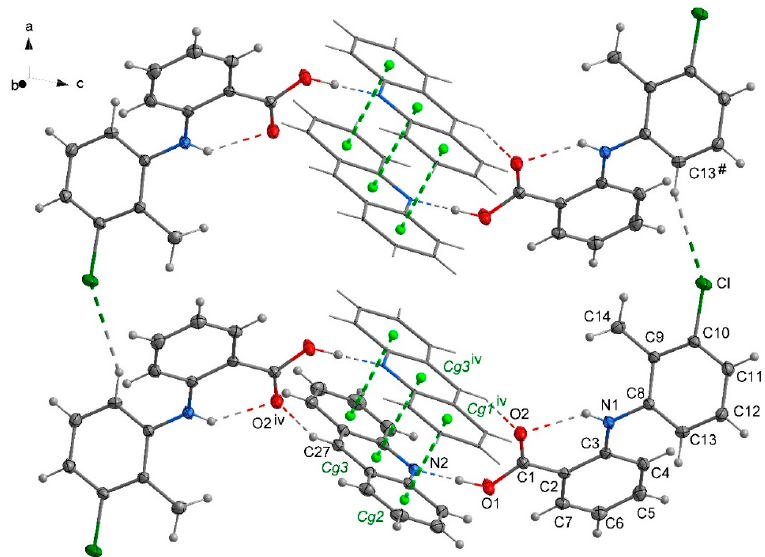
Figure 4. Packing crystal 3 showing arrangement of the complexes of acridine and tolfenamic acid. Stacking interactions of acridine molecules are shown by green dashed lines linking centers of aromatic rings (centroids of rings-Cg-marked as green balls; Cg1 (C28/C29/C30/C31/C32/C33); Cg2 (C21/C22/C23/C24/C25/C26); Cg3 (N2/C21/C26/C27/C28/C33)). Symmetry codes: iv = − x + 1, − y + 1, − z; # = x + 1, y,